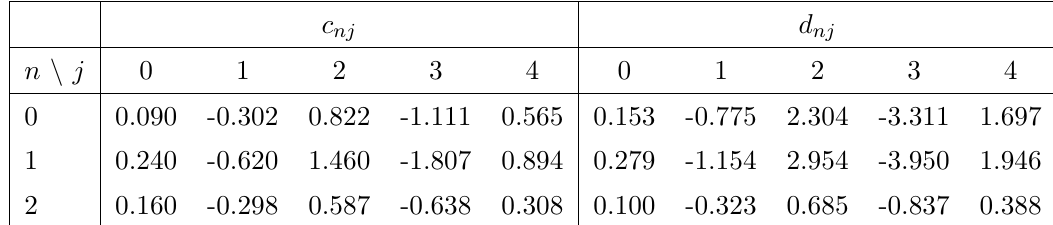
Table 1 . Fitted coe(cid:14)cients c nj and d nj of [( M (cid:0) M (cid:3) ) =M (cid:3) ] j in the polynomials c n ( M ) and d n ( M ) that appear in the decompositions of the imaginary parts of (cid:13) 0 and t 2